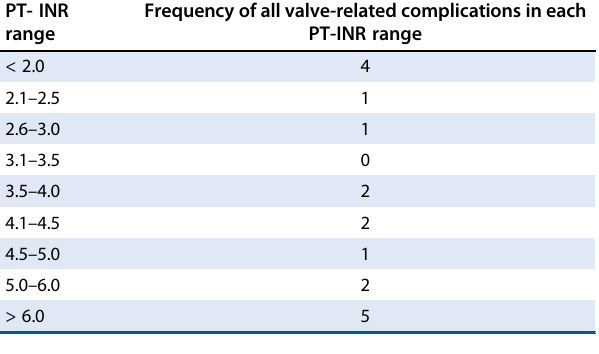
Table 4: Assessment of quality of anticoagulation of the study subjects with mechanical heart valve prosthesis